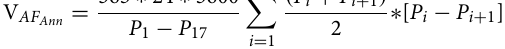
P i = 17 points of FDC probability that P 1 = 99.99% and P 17 = 0.01%. F i = The amount of the river flow with the probability of the occurrence of P